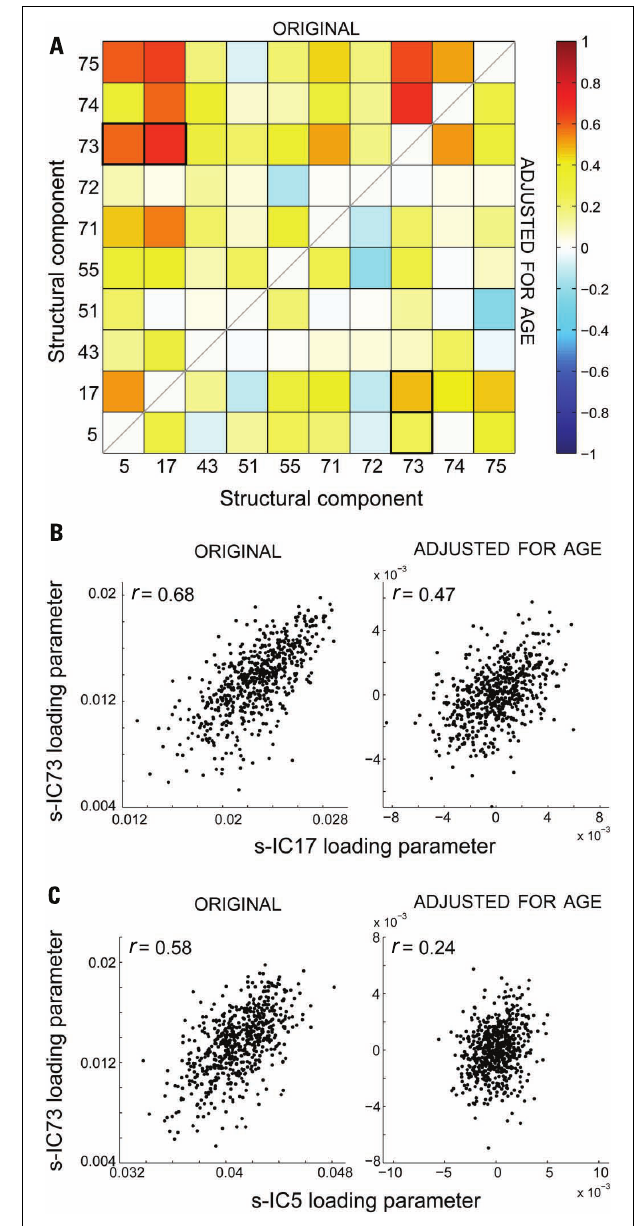
FIGURE 6 | (A) Structural network correlations (SNC) of the 10 selected structural components.The top half of the matrix is without age adjustment (original) and the bottom half is after age adjustment. (B) An example of the effect of adjusting for age, where the adjustment does not remove the significant correlation between the components for s-IC73 and s-IC17. (C) An example of the effect of adjusting for age, where the adjustment does remove the significant correlation between the components for s-IC73 and